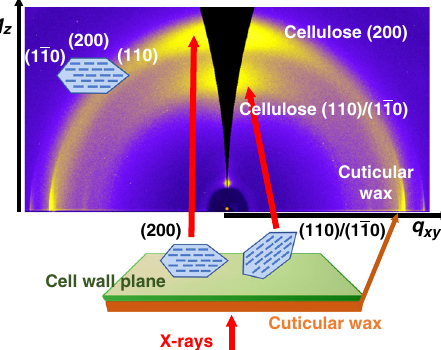
Fig. 5 Schematic of crystal orientation of cellulose with respect to the plane of the cell wall. The out-of-plane grazing-incidence scattering from primary cell walls arises from preferentially oriented cellulose crystals, whereas in-plane scattering arises from epicuticular wax crystals. Crystal planes that lead to out-of-plane re fl ections are denoted in the two populations of cellulose crystals shown. The presence of both (110)/(1 (cid:1) 10) or (200) along the out-of-plane direction in GIWAXS data suggests that two populations of crystallites are present in primary cell walls, each with either (110)/(1 (cid:1) 10) or (200) planes stacked parallel to the plane of the cell wall. Non-crystalline polysaccharides, such as pectin and hemicellulose, are not shown. Inset, top left: cross-section of cellulose crystals with labeled crystal